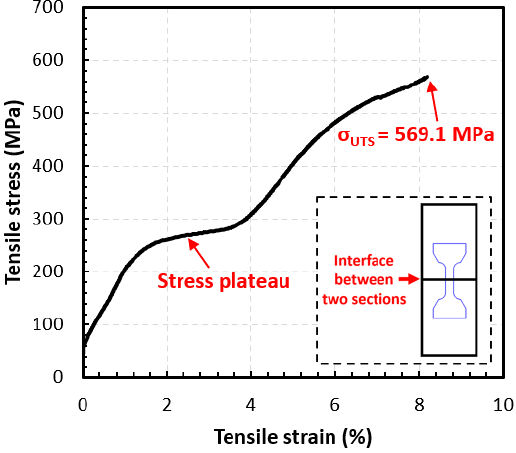
Figure 7. The stress–strain curve of the DED as-deposited bi-metallic structure. The miniature tensile sample was extracted with the interfacial line located at the center of the gauge section.